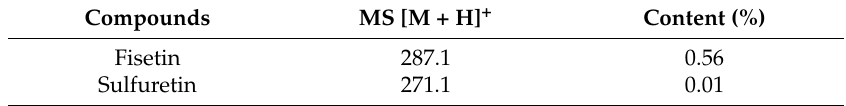
Table 1. Quantitative analysis of biologically active compounds in Rhus verniciflua Stokes (RVS) extract.